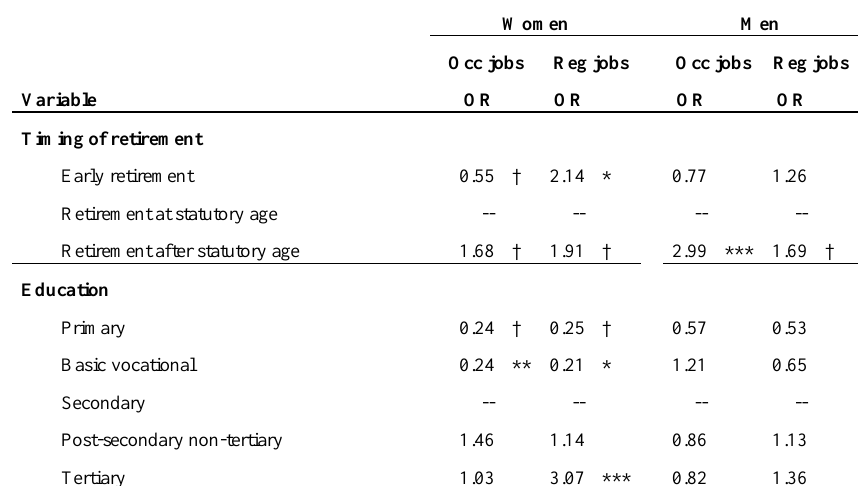
Table 2. Multinomial logistic regression with: timing of retirement, education, year of retirement, retirement planning, and group (1) and (2) of retirement